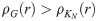
Minimal absolute amplifier.(A) This bowtie-shaped graph is the smallest absolute amplifier of weak selection under temperature initialization. (B) The difference in fixation probabilities between this graph and the complete graph K6 is plotted against mutant fitness, r. The dashed line shows the linear approximation to this difference at r = 1, computed using our weak-selection methods. Although this difference is increasing at r = 1 (because the graph is an absolute amplifier of weak selection), the difference is negative for all values of r. Thus this graph does not amplify selection in the usual sense of ρG(r)>ρKN(r) for all r > 1.